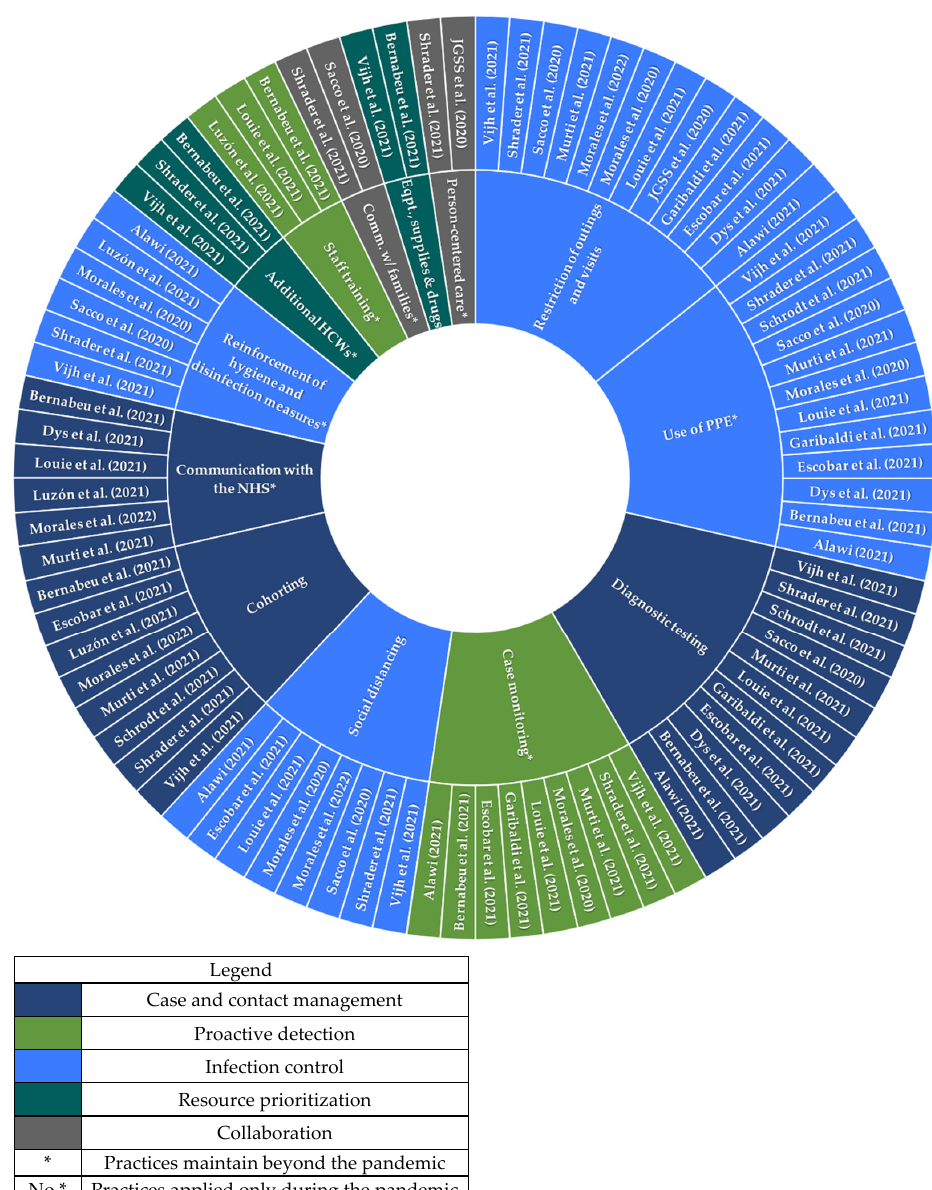
Figure 3. Frequency of good practices according to their categories. Comm.: Communication; Eqpt.: Equipment; HCWs: healthcare workers; JGSS: Japan Geriatrics Society Subcommittee; NHS: national health system; PPE: Personal protective equipment; w/: with. * Practices maintain beyond the pandemic. Those practices not marked with an asterisk apply only during the pandemic. Refs. [14–28].